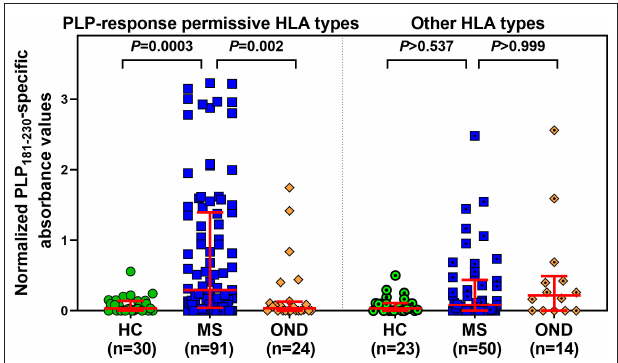
FIGURE 4 | Comparison of anti-PLP 181 − 230 antibody reactivity in individuals carrying PLP response-permissive HLA types vs. other HLA types. There were no significant differences between HC, MS, and OND groups in the patients carrying other HLA